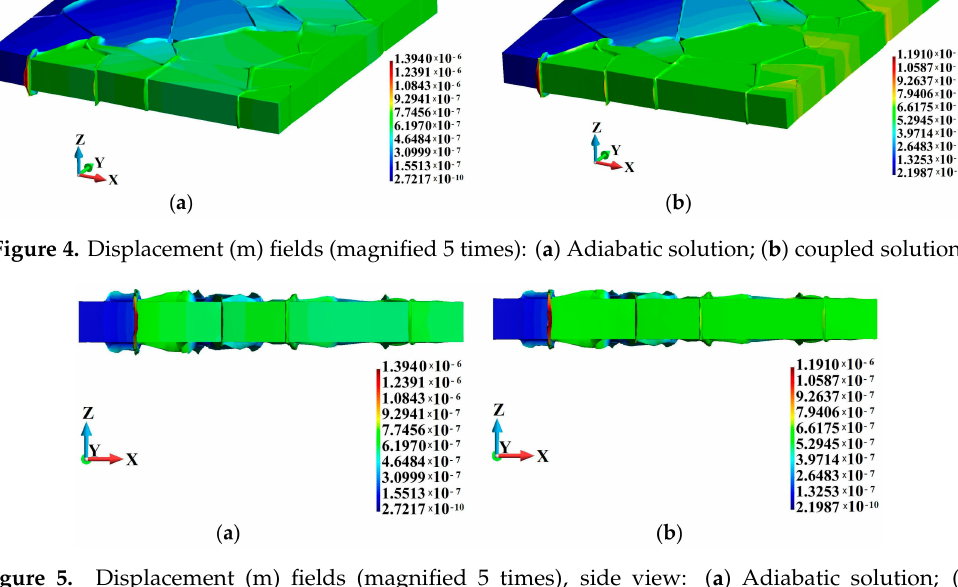
Figure 5. Displacement (m) fields (magnified 5 times), side view: ( a ) Adiabatic solution; ( b ) coupled solution.